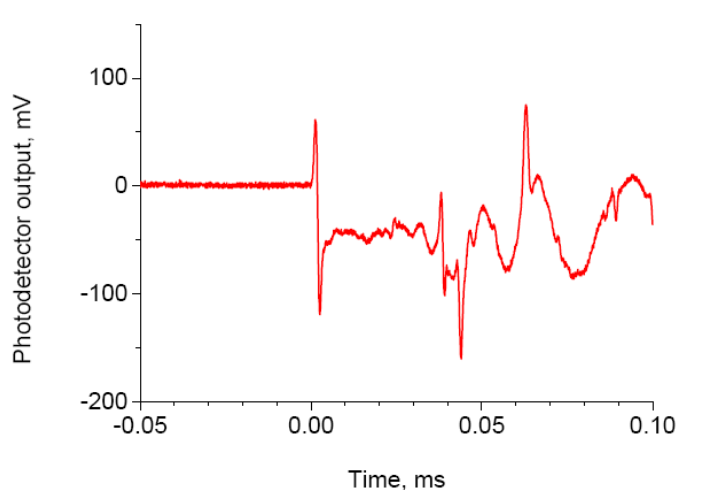
Figure 8. A typical glued FBG sensor response to a pencil lead